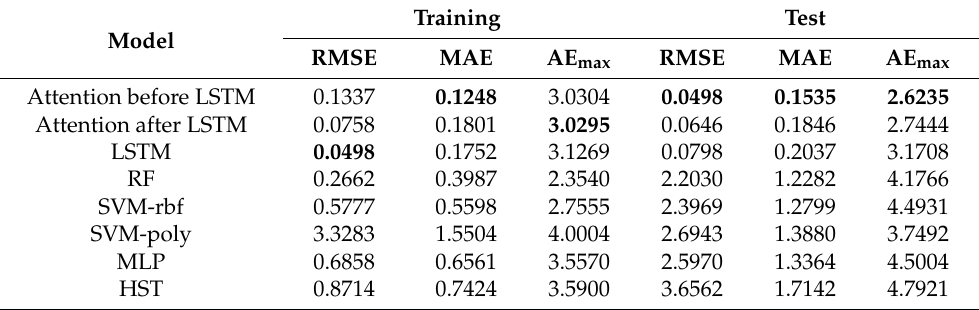
Table 4. Performance comparison of different models.